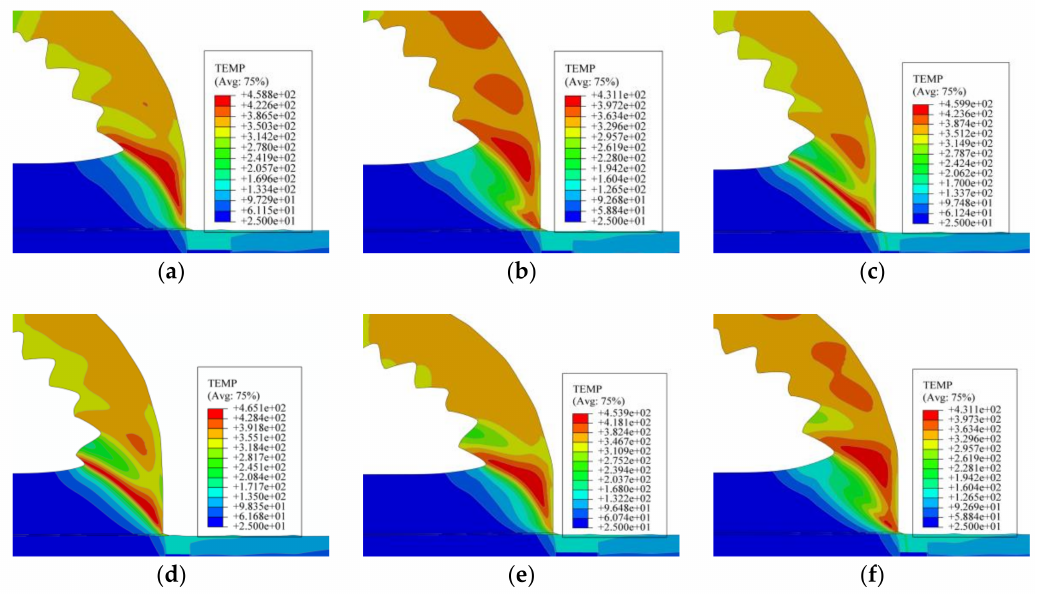
Figure 15. Cutting temperature under condition of v s = 450 m/min, f r = 0.2 mm/r: ( a ) The fully formed saw-tooth segments; ( b ) The new segment began to form; ( c ) The development of the shear plane; ( d ) Adiabatic shear instability in the shear plane; ( e ) Shearing slip of the chip material; and ( f ) The new saw-tooth segment was fully